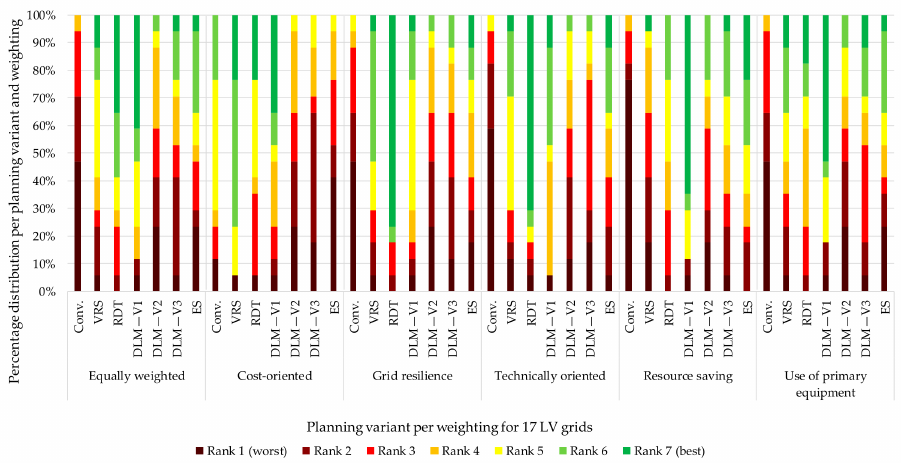
Figure 38. Percentage distribution of the ranking consolidated for 17 low-voltage grids in relation to the different weightings for the progressive scenario with